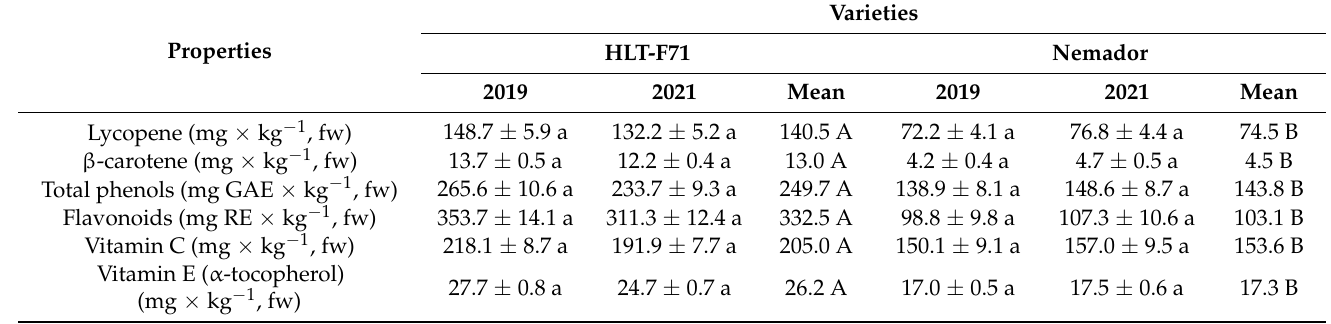
Table 3. Lycopene, β -carotene, total phenols, flavonoid, vitamin C and tocopherol contents of tomato varieties grown organically during the two growing seasons. Data are expressed as mean ± S.E. with four